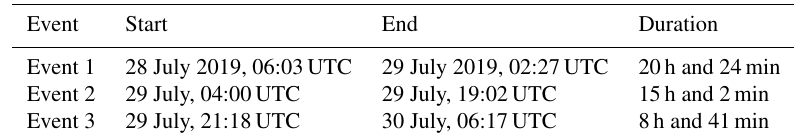
Table E1. Start, end, and duration of the three events used to assess the duration of drainage-water flow from ML pots and the specification of a drainage-water flow sensor.